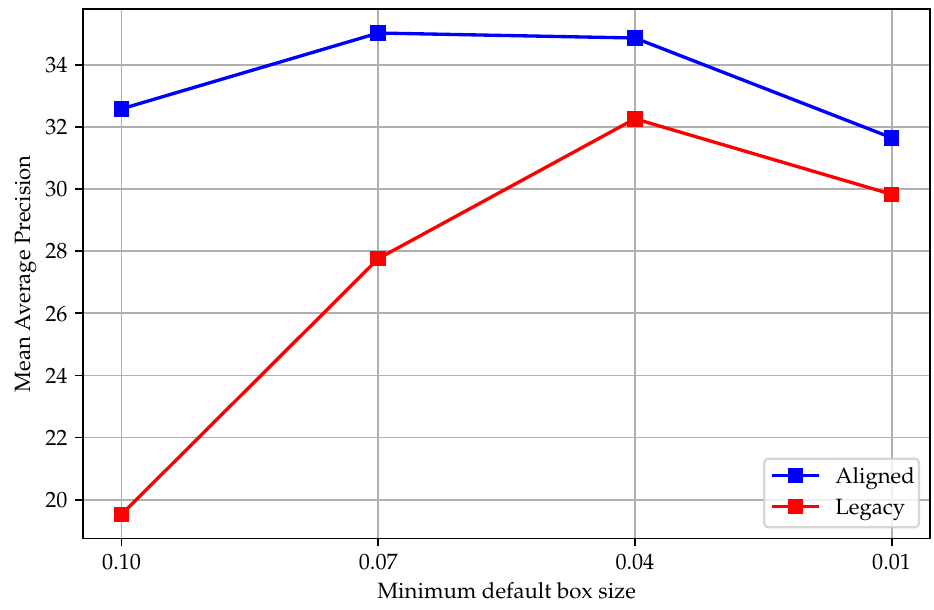
Figure 6. Performance of SSD300 with various default box sizes.